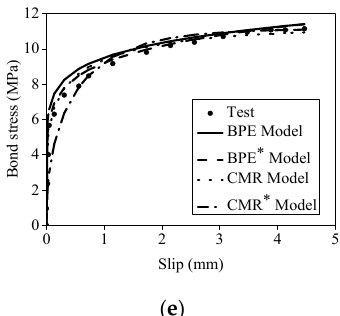
Figure 16. Comparisons between experimental and analytical τ - s curves: ( a ) R1-C1-20-Y-2; ( b ) R2-C1-16-Y-3; ( c ) R2-C1-20-Y-1; ( d ) R 3 -C1-16-Y-1; and, ( e ) R 3 -C1-20-Y-3.